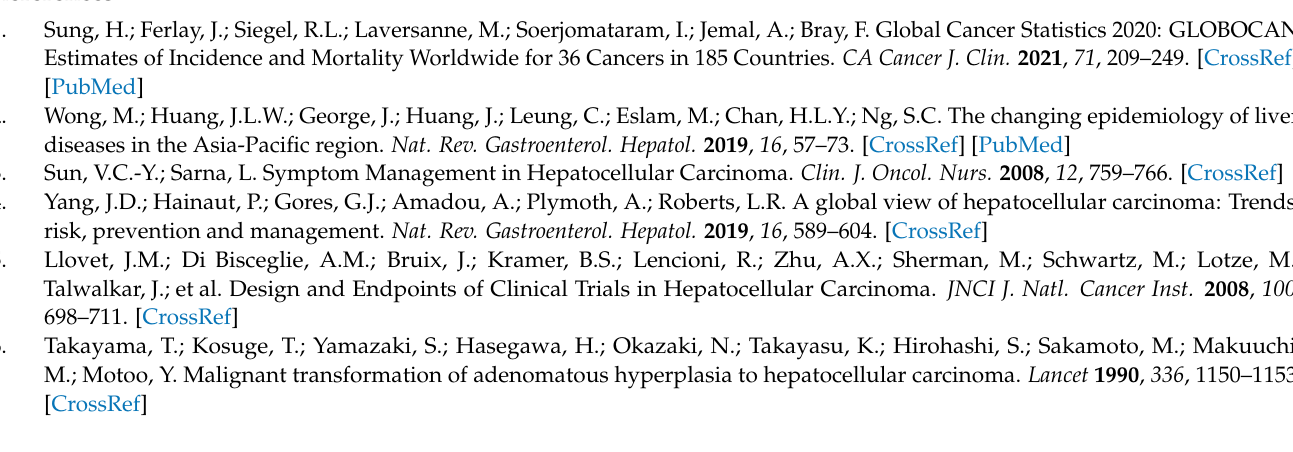
diagnostic cutoff values of 4 serum markers; Table S4: The clinical characteristics of HCC patients in the comparison